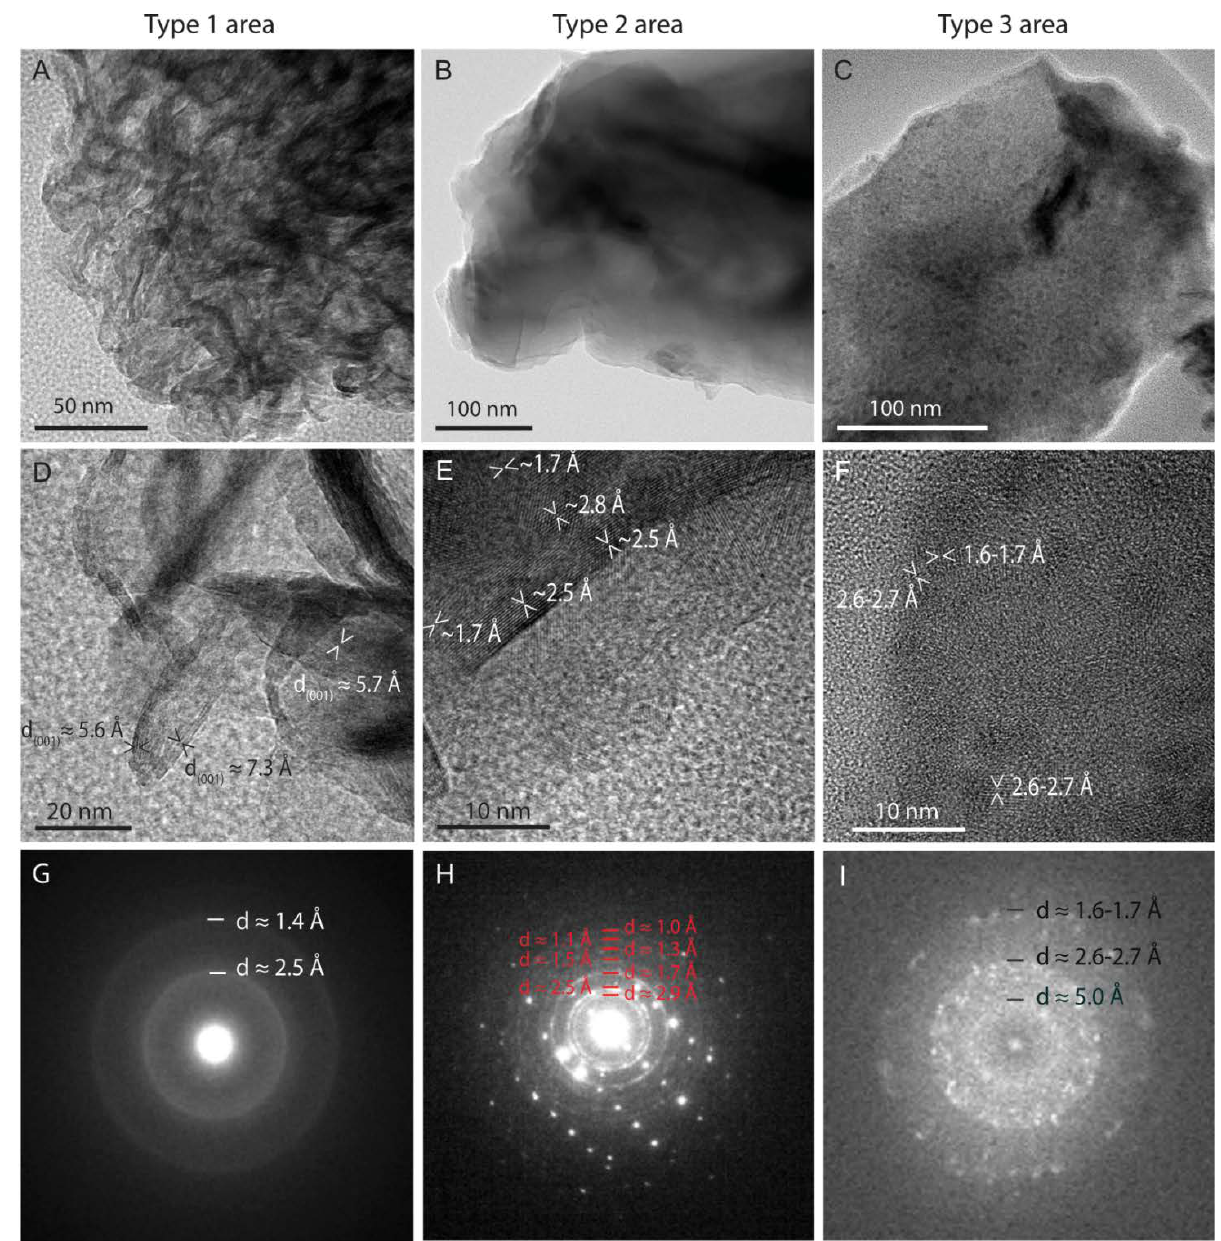
Figure 7. TEM images showing three nanoscale type areas in the field site Mn precipitates. ( A ) Sheets constructed of very few layers elongated along the octahedral chains. In places, the sheets bend and curl under to give a scroll-like appearance. ( B ) Polycrystalline sheets. ( C ) Flakes with particles. ( D , G ) HRTEM and SAED pattern of sheets in ( A ). ( E , H ) HRTEM and SAED pattern of polycrystalline sheets in ( B ). ( F , I ) HRTEM and the corresponding fast Fourier Transform (FFT) pattern of particles in ( C ). ( G ) SAED of ( A